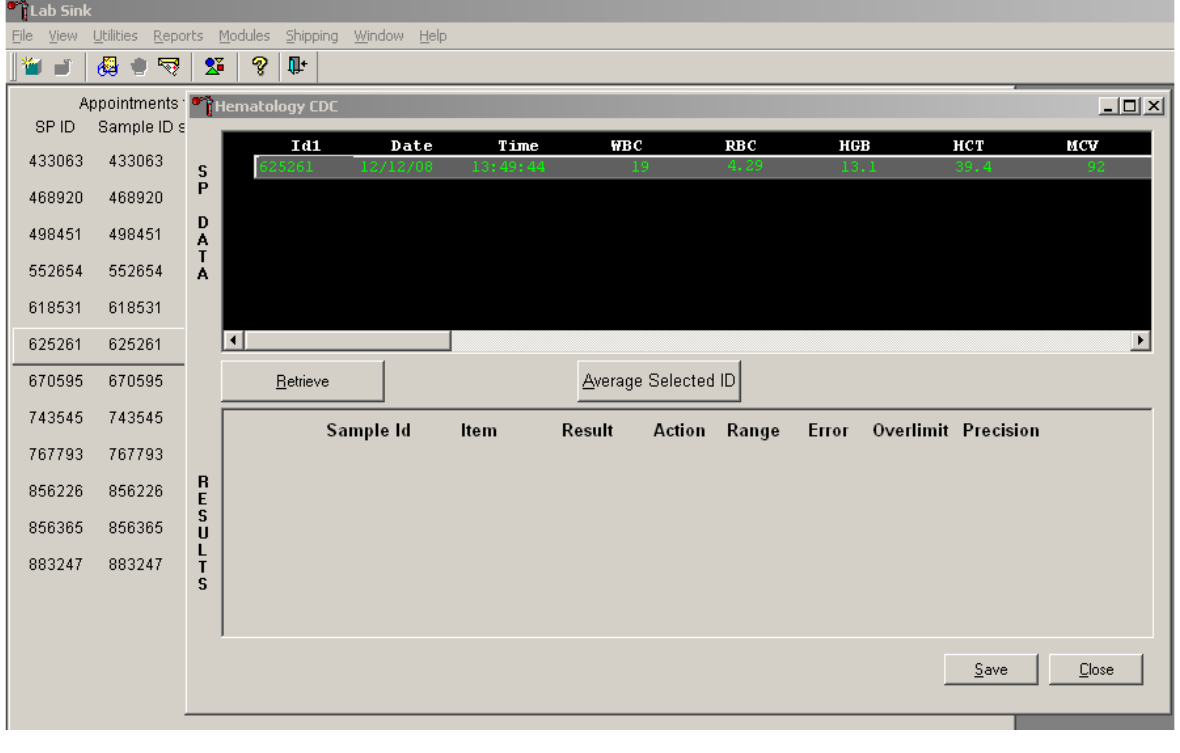
horizontal scroll bar at the bottom of the SP Data section and drag the scroll bar to the left or right. Alternatively, to view the SP data for all parameters, use the mouse to direct the mouse arrow to the small scroll arrows on the left and right edges of the horizontal scroll bar, and left